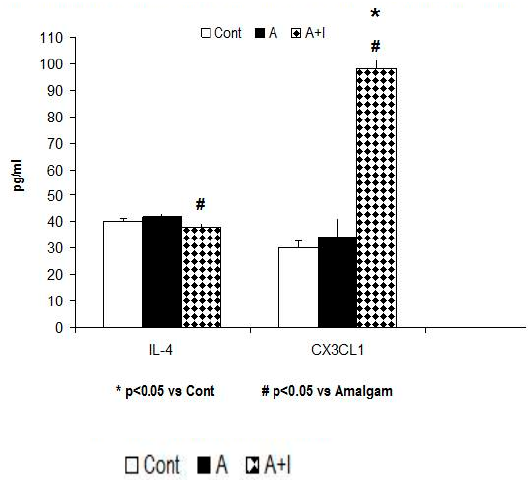
Figure 6. Patients with long-term titanium dental implants and amalgams have lower IL-4 levels as